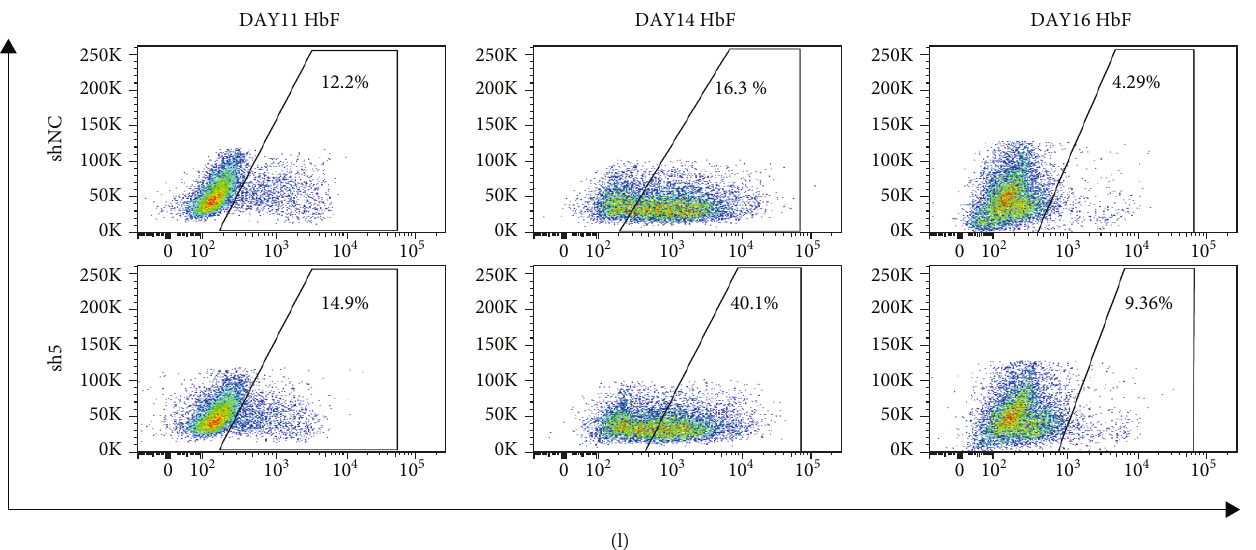
Figure 2: E ff ects of ANTXR1 overexpression or knockdown on γ -globin mRNA and protein levels. (a, b) ANTXR1 was overexpressed using the PHAGE-fEF-1a-IRES-ZsGreen-2 vector in K562 cells, while cells transfected with the empty vector served as controls. ANTXR1 and γ -globin mRNA levels were measured by qRT-PCR. (c) In K562 cells, ANTXR1-sh1-5 was separately inserted into the pSIH1-H1- copGFPshRNA vector to test the knockdown e ffi ciency of ANTXR1 . Of the fi ve shRNA vectors, ANTXR1-sh1 and ANTXR1-sh5 had the most signi fi cant knockdown e ffi ciencies of 82% and 88%, respectively. (d) After the K562 cells were infected with ANTXR1-sh1, ANTXR1-sh5, and control shNC, respectively, the mRNA levels of ANTXR1 and γ -globin were determined using qRT-PCR. ANTXR1-sh5 had a greater e ff ect on γ -globin expression than ANTXR1-sh1. (e) Western blot analysis was used to detect ANTXR1 and γ -globin levels after infection of K562 cells with ANTXR1 overexpression vectors and interference vectors (ANTXR1-sh1 and ANTXR1-sh5). (f) At days 0, 4, and 7 of erythroid di ff erentiation after infection of HUDEP-2 cells with ANTXR1-sh5 and shNC vectors, ANTXR1, γ -globin, and β -globin expression was determined by western blotting. (g, h) After infection of umbilical cord blood CD34 + cells with overexpression of the ANTXR1 vector, the mRNA levels of ANTXR1 and γ / γ + β globin ratio at days 11, 14, and 16 of erythroid di ff erentiation were determined by qRT-PCR. (i, j) After infection of umbilical cord blood CD34 + cells with ANTXR1-5 and shNC vectors, the mRNA levels of ANTXR1 and γ / γ + β globin ratio at days 11, 14, and 16 of erythroid di ff erentiation were determined by qRT- PCR. (k) After infection of umbilical cord blood CD34 + cells with the ANTXR1 overexpression vector and interference vector, the protein levels of ANTXR1, γ -globin, and β -globin at days 11, 14, and 16 of erythroid di ff erentiation were detected by western blotting. (l) Umbilical cord blood CD34 + cells interfered with ANTXR1 and were cultured under conditions that promoted erythroid maturation. The cells were collected at days 11, 14, and 16, respectively. Flow cytometry was used to detect HbF-immunostained cells (F cells). These experiments were repeated three times. The error bar represents the SD. ∗ P < 0 : 05 and ∗∗ P < 0 : 01 . NC designates the negative